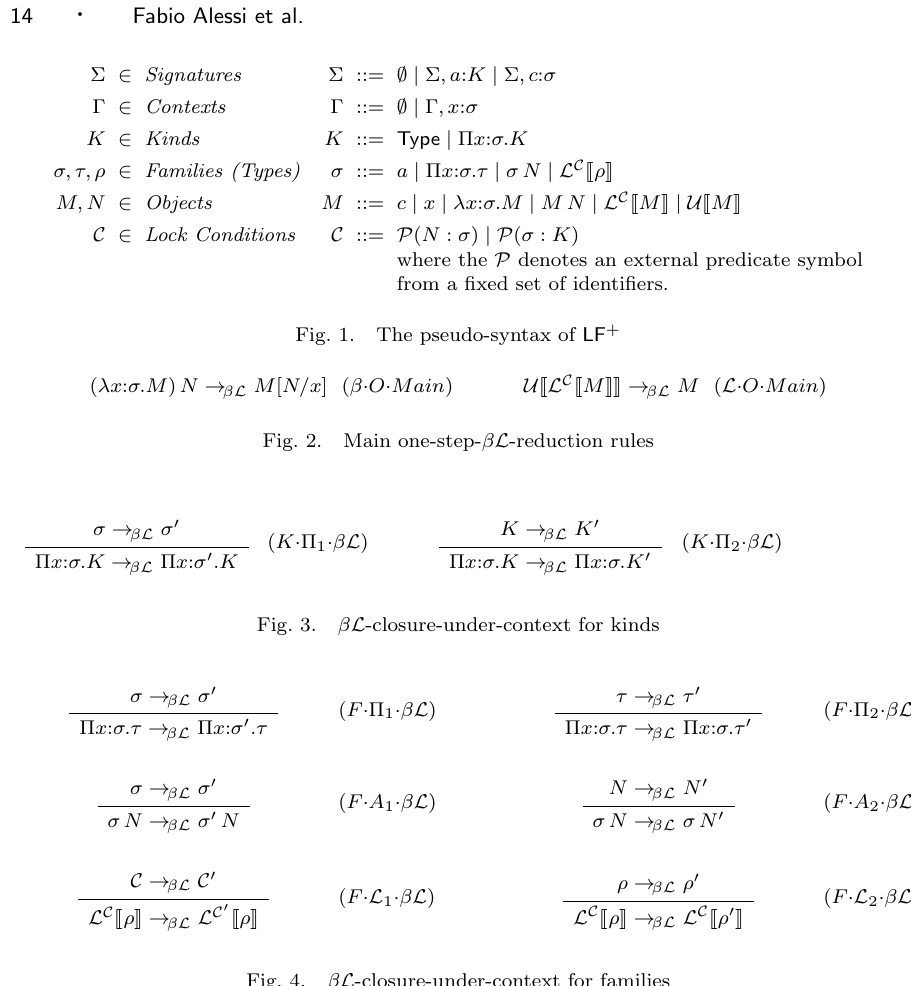
Fig. 1. The pseudo-syntax of LF +